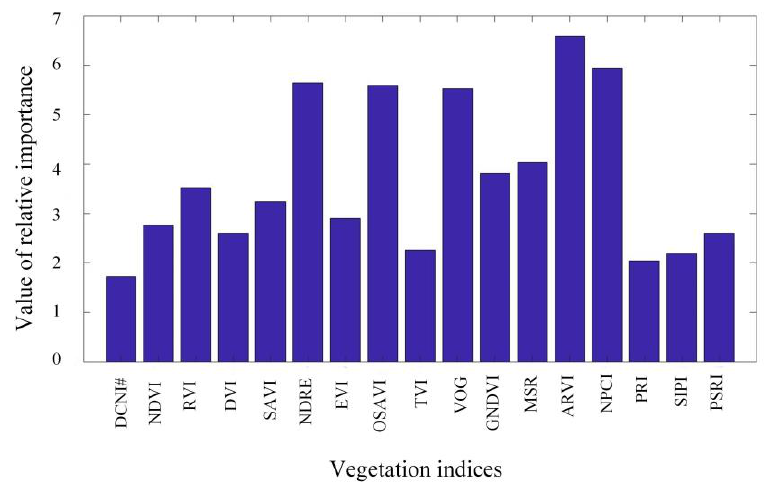
Figure 6. Distribution of importance of vegetation indices based on random forest.